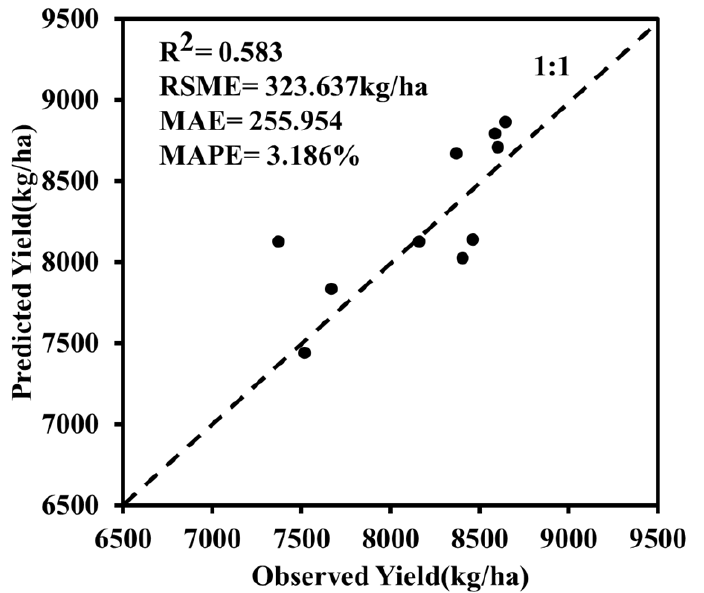
Figure 6. The R 2 , RSME, MAE, and MAPE for the relationship between the observed and predicted yields based on the weighted optimal VI group. The dashed line is the 1:1 line.